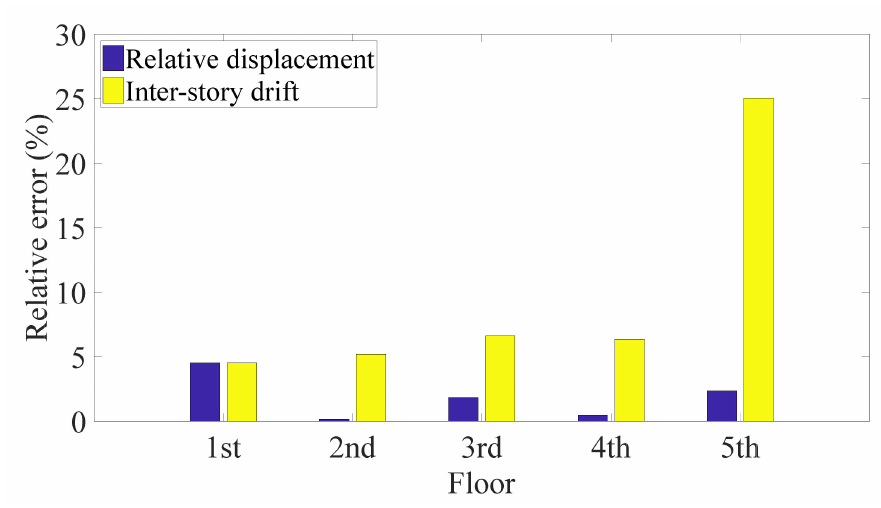
Figure 13. Relative error of peak relative displacement and inter-story drift of five-story